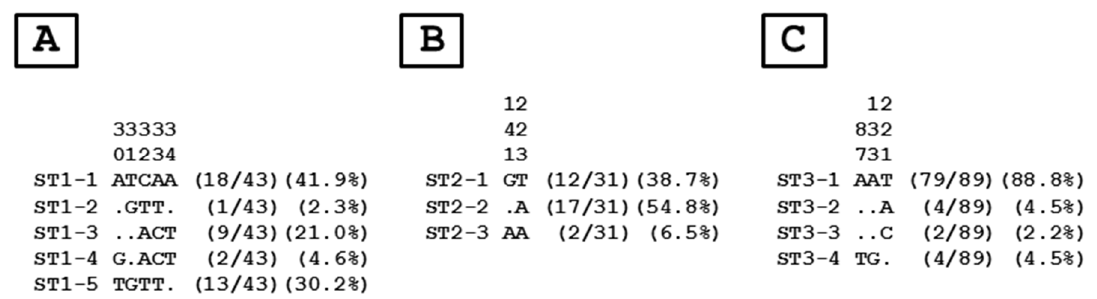
Figure 2. Alignment of partial SSU rDNA gene sequences from Blastocystis sp. ST1 ( A ), ST2 ( B ), and ST3 ( C ) isolates colonizing Syrian refugees. Positions of variable nucleotides in comparison to reference sequences (genotypes ST1-1, ST2-1 and ST3-1) are indicated above the alignment (vertical numbering). Genotypes identified within each ST are indicated on the left of the alignments. Nucleotides identical to those of the reference sequences are represented by dashes. On the right of each alignment are reported the total number and percentage of isolates identified in Syrian refugees for each genotype.